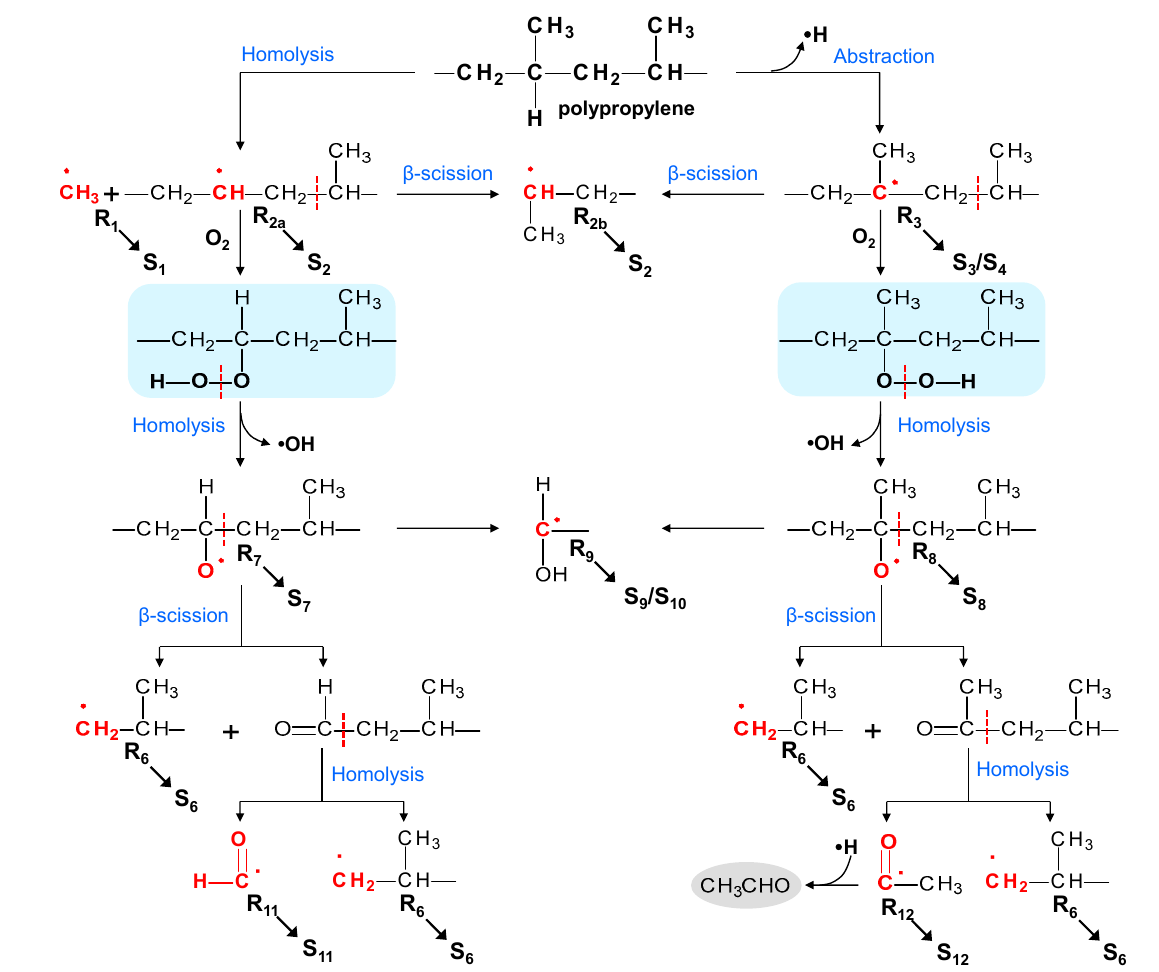
Scheme 2. The inferred reaction scheme for the thermo-oxidative degradation of pristine